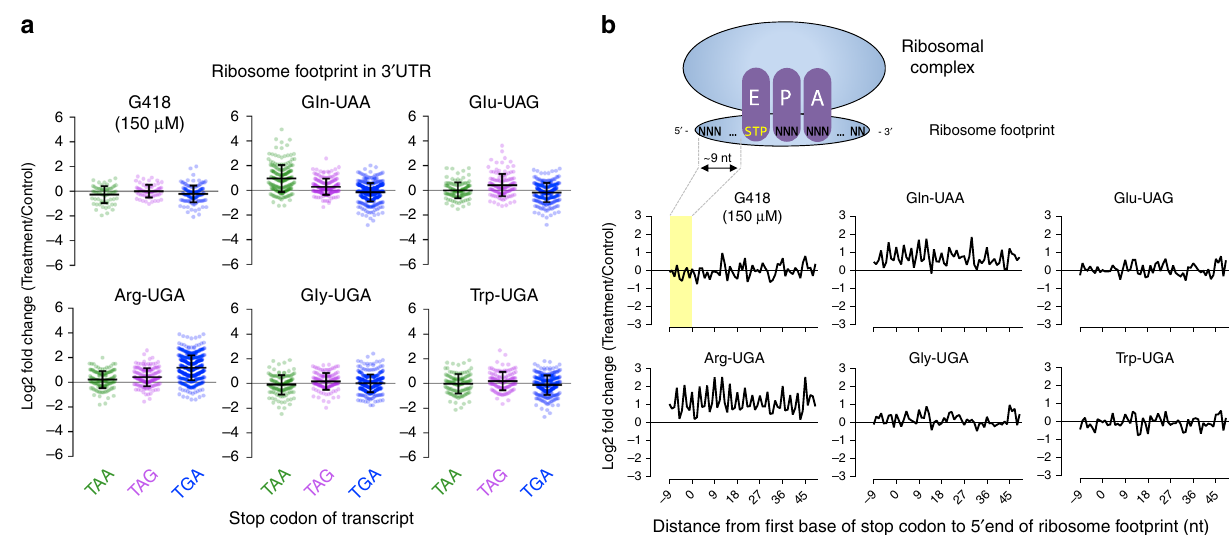
Fig. 4 Ribosome pro fi ling of ACE-tRNA on transcriptome-wide 3 ′ UTRs. a Ribosome footprint densities on 3 ′ UTRs are plotted as log2-fold change for reads of treated cells vs. control (puc57GG empty vector) as described in the materials and methods. Transcripts were grouped by their endogenous UAA, UAG, and UGA stop codons. Each point represents the mean of two replicates for a transcript. Error bars show Mean± SD of the log2-fold changes. b The average log2-fold change of normalized ribosome footprint occupancy was plotted for each nucleotide from − 9 to + 50 nt surrounding stop codons of transcriptome (18,101 sequences). The cartoon illustrates the ~9 nt offset from the 5 ′ end of ribosome footprint to the fi rst base position of stop codon in the ribosome E-site. ACE-tRNA genes used for 4× constructs are Trp-chr17.trna39 (UGA), Gly-chr19.trna2 (UGA), Arg-chr9.trna6 (UGA), Gln-chr17. tRNA14 (UAA), and Glu-chr13.trna2 (UAG). Sequences are located in Supplementary Data